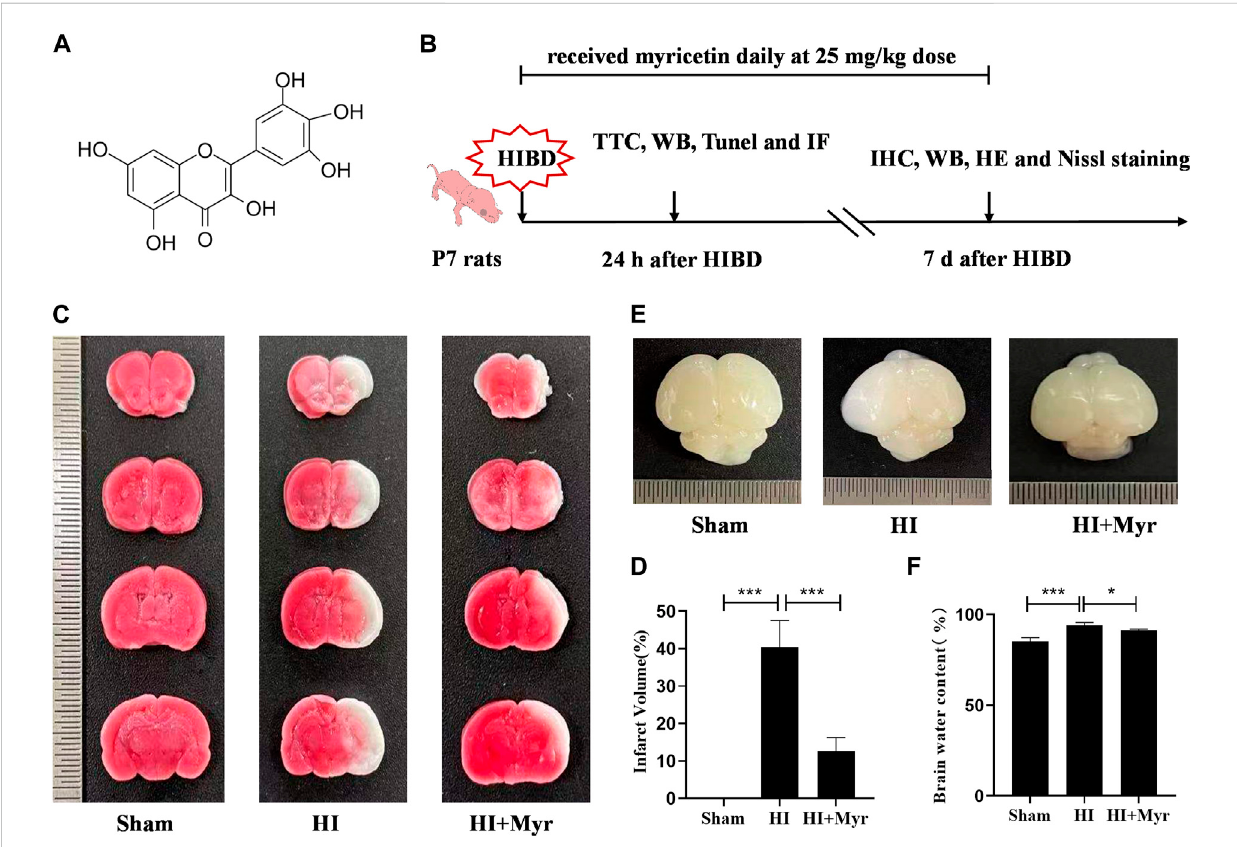
FIGURE 1 Myricetin attenuated brain infarction and edema. (A) The chemical structure of myricetin. (B) The timeline of experiment design for in vivo experiments. HIBD: hypoxic-ischemic brain damage. (C) The representative images of TTC staining of coronary brain sections 24 h after HI brain injury. (D) Quantitative analysis of infarct volume based on TTC staining ( n = 5 per group). (E) The representative images of the brain from each group 24 h after HI brain injury. (F) The ratio of wet and dry in each group ( n = 5 per group). The data are presented as mean ± SD. * p < 0.05; *** p < 0.001. Scale bar: 0.5